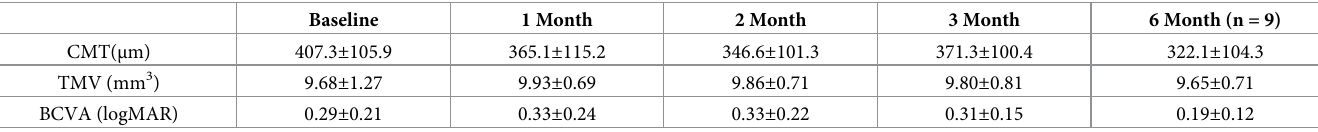
Table 3. Changes in SD-OCT parameters and visual acuity after subthreshold micropulse laser (n = 11).